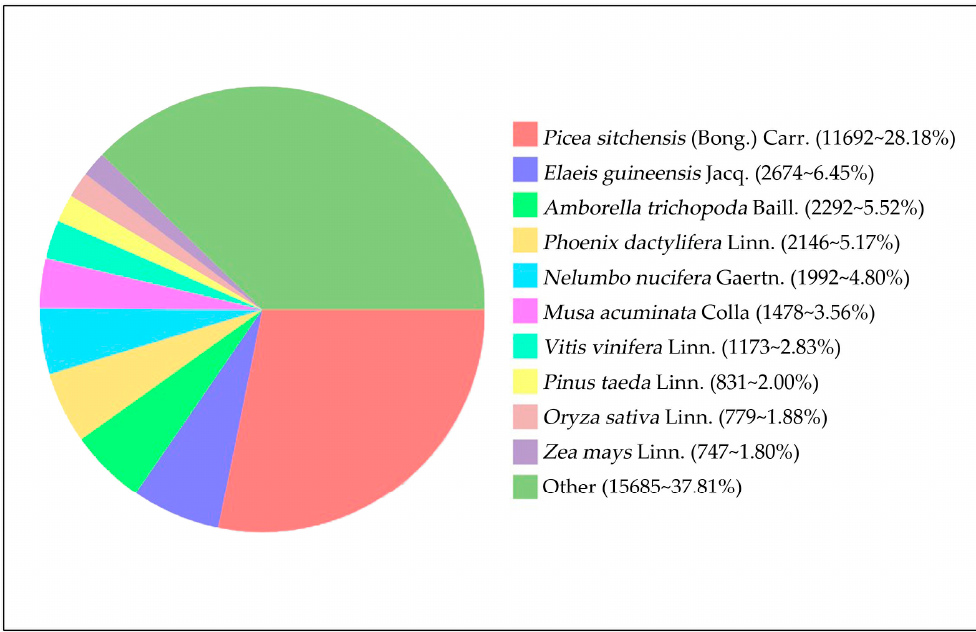
Figure 3. The Unigene Number Annotated in the Public Database Searches.